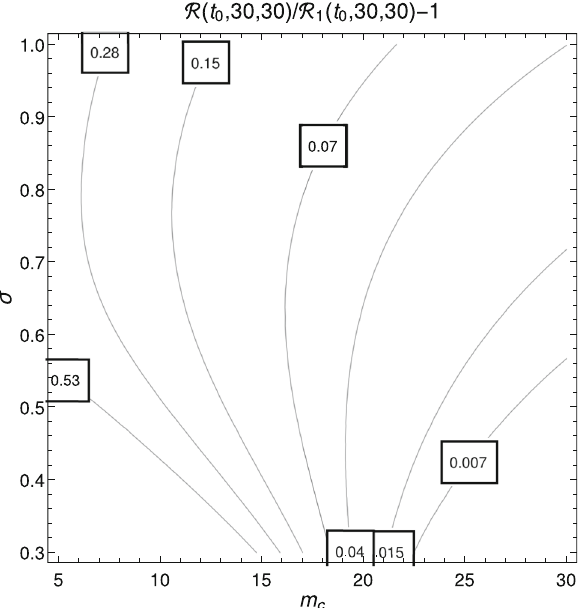
Fig. 9 Contour of ( R ( t 0 , 30 M (cid:2) , 30 M (cid:2) )/ R 1 ( t 0 , 30 M (cid:2) , 30 M (cid:2) ) − 1 ) in the parameter space of PBH mass function